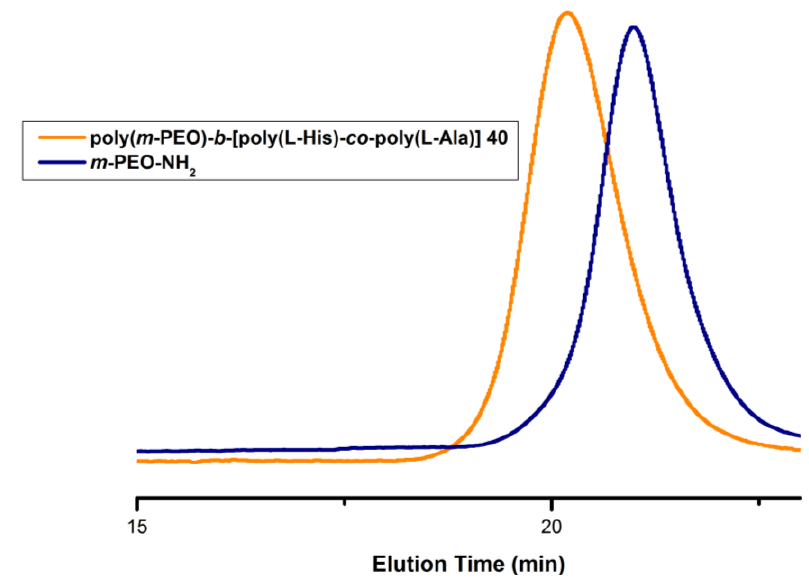
Figure 5. SEC eluogram of m -PEO- b -poly(His- co -Ala) with 40% alanine to histidine molar ratio. Table 1. Molecular characteristics of the synthesized